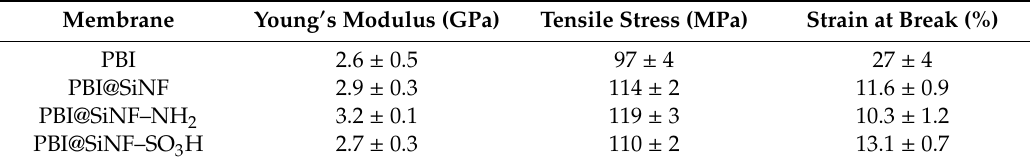
Table 2. Mechanical properties of the PBI composite membranes containing SiNFs.